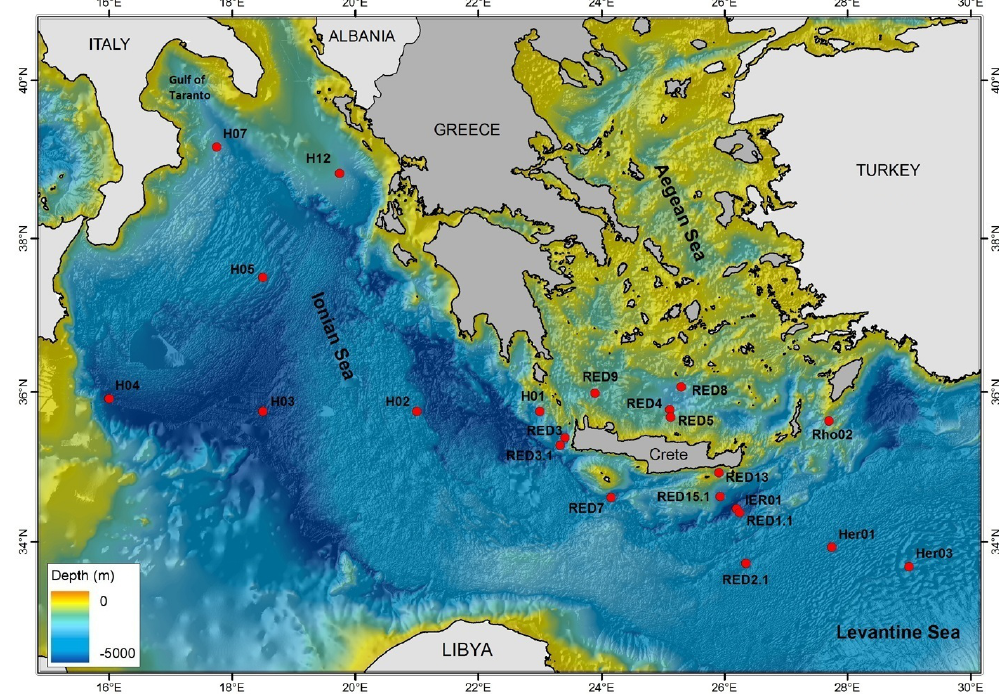
Fig. 1. Location of sampling sites across the eastern Mediterranean Sea (see also Table 1). The map was produced using the GEBCO Digital Atlas (IOC, IHO and BODC,